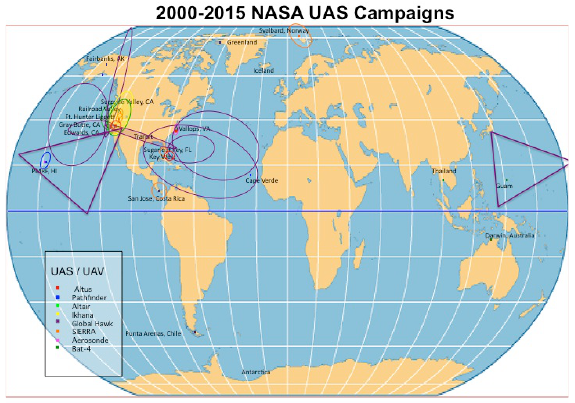
Figure 1. Map of NASA UAS missions